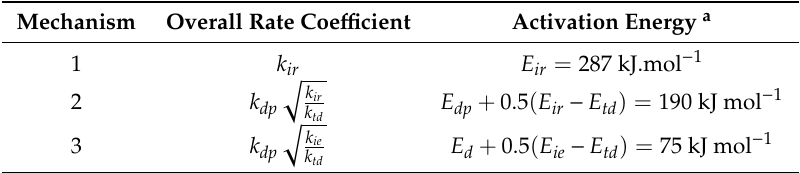
Table 7. Theoretical determination of overall activation energies by Smolders and Baeyens [122], based on the reaction schemes and rate laws in Table 6.